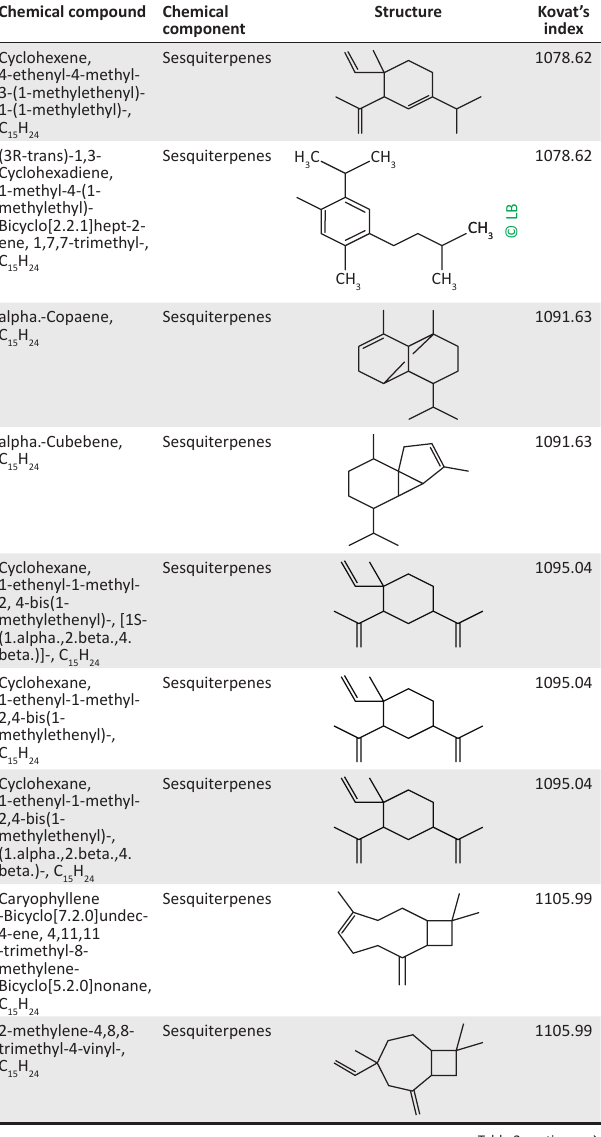
TABLE 2: Kovat’s index of chemical compounds and structural formula for the solvent-free microwave extraction. Chemical compound Chemical Structure component